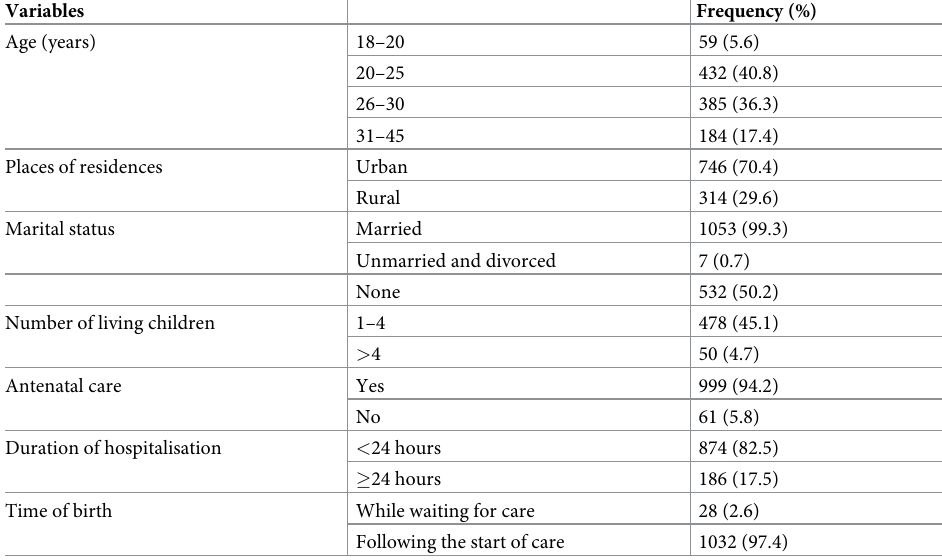
Table 1. Sociodemographic characteristics of study participants, Amhara National, Regional State Referral Hos- pitals, Ethiopia, 2018 (n =